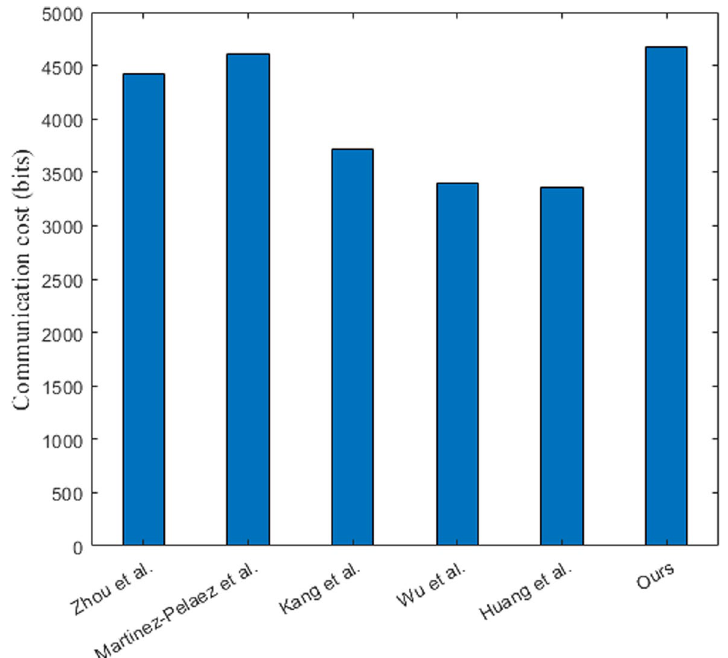
Fig. 7 Comparisons of communication